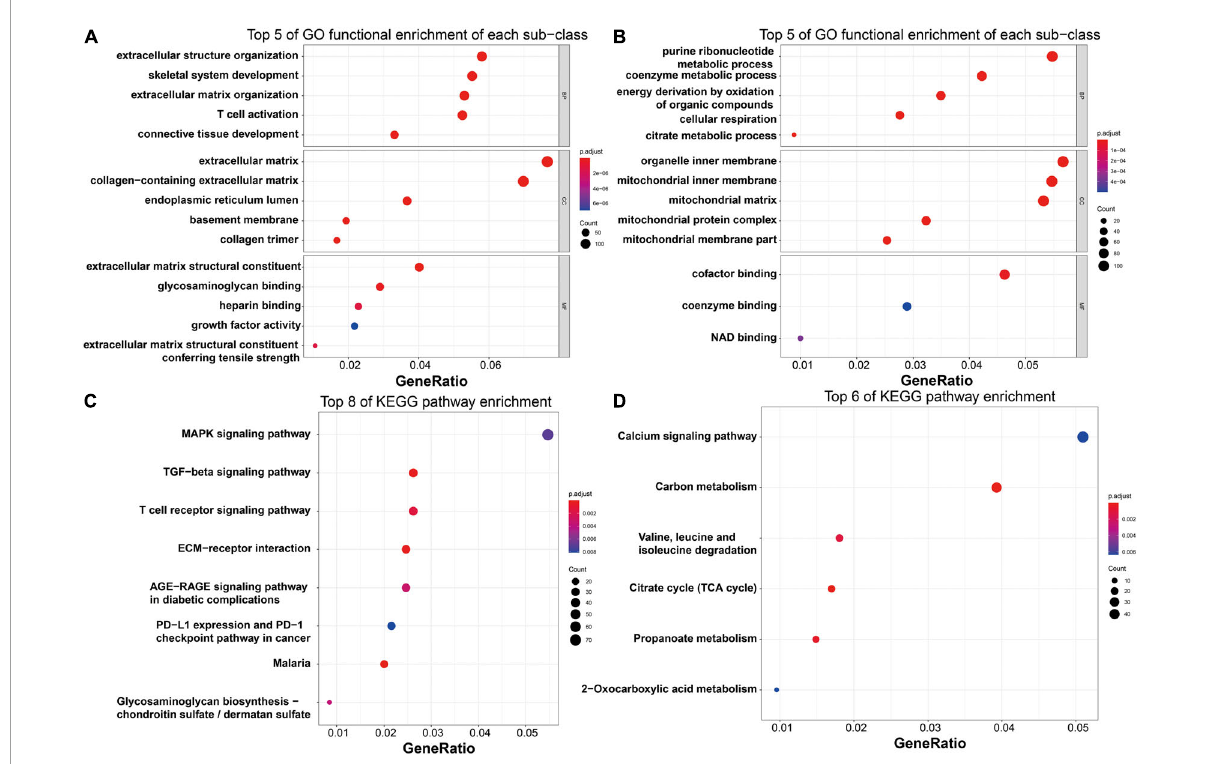
FIGURE6 Functional enrichment analysis of the robust HF-related DEGs. (A) Top five enriched GO functions of the upregulated genes regarding BP, CC, and MF terms, as visualized by bubble plots. (B) Top five enriched GO functions of the downregulated genes regarding BP, CC, and MF terms, as visualized by bubble plots. (C) Top eight enriched KEGG pathways of the upregulated genes, as visualized by bubble plots. (D) Top eight enriched KEGG pathways of the downregulated genes, as visualized by bubble plots. HF, heart failure; DEGs, differentially expressed genes; GO, gene ontology; BP, biological process; CC, cellular component; MF, molecular function; KEGG, Kyoto Encyclopedia of Genes and